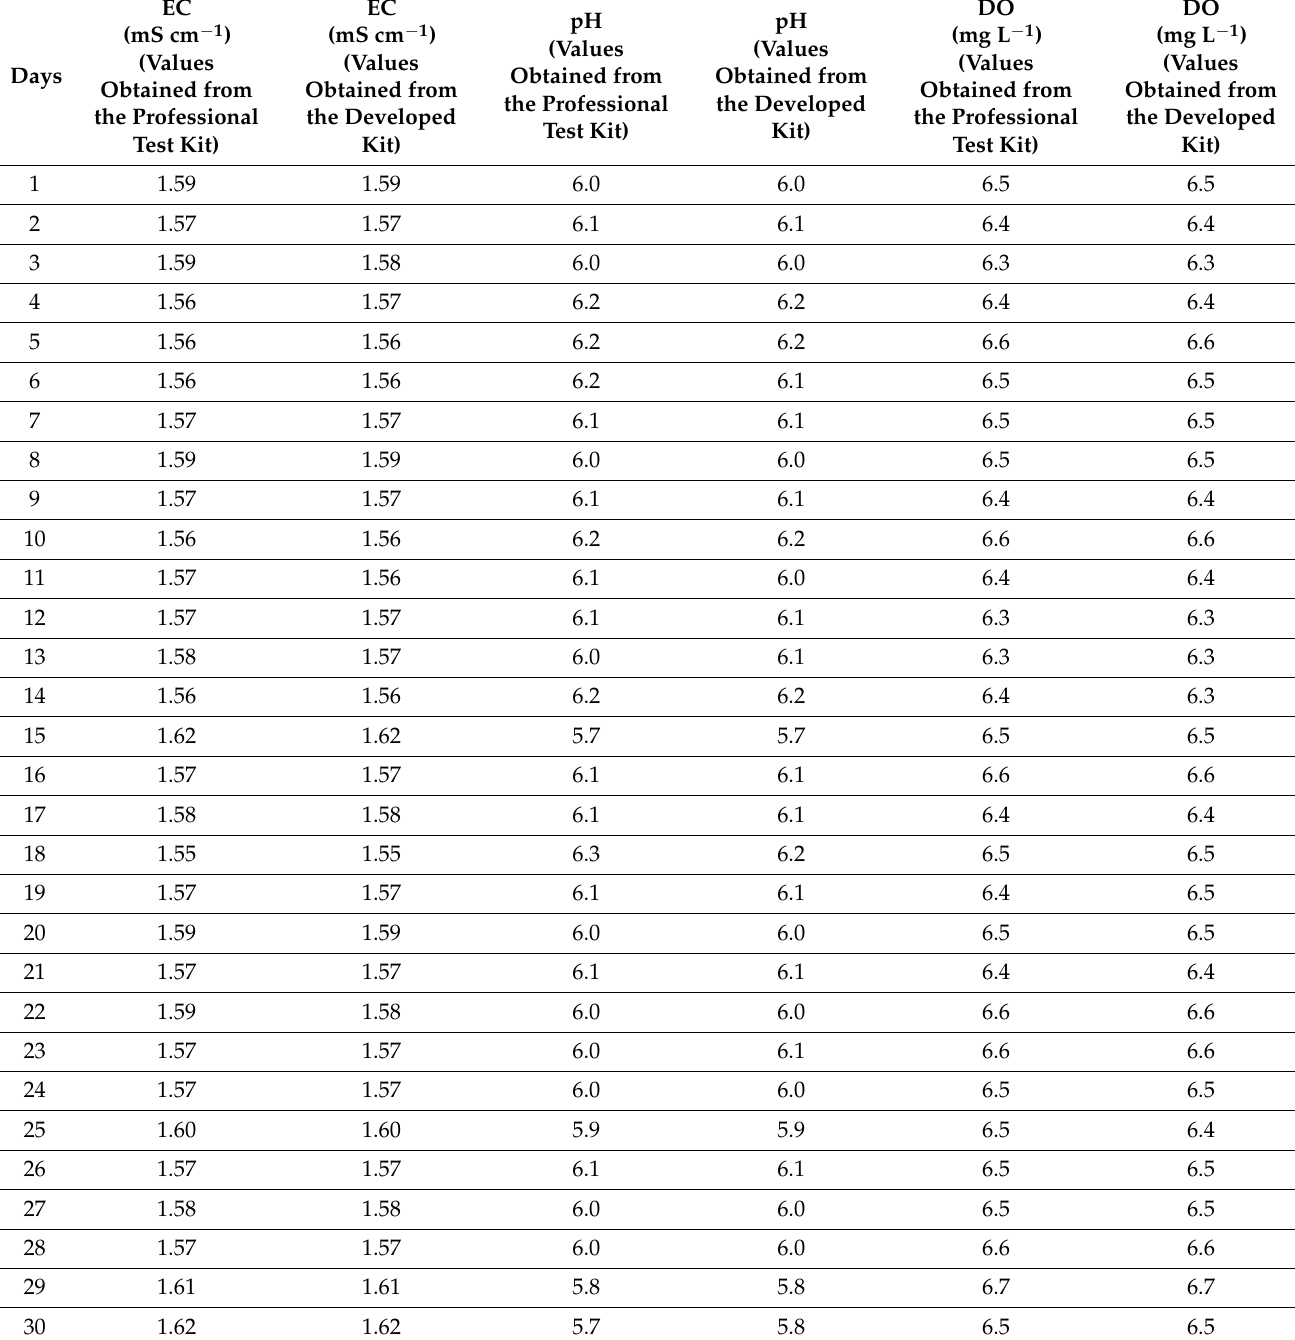
Table 1. Specific parameters of the liquid in the